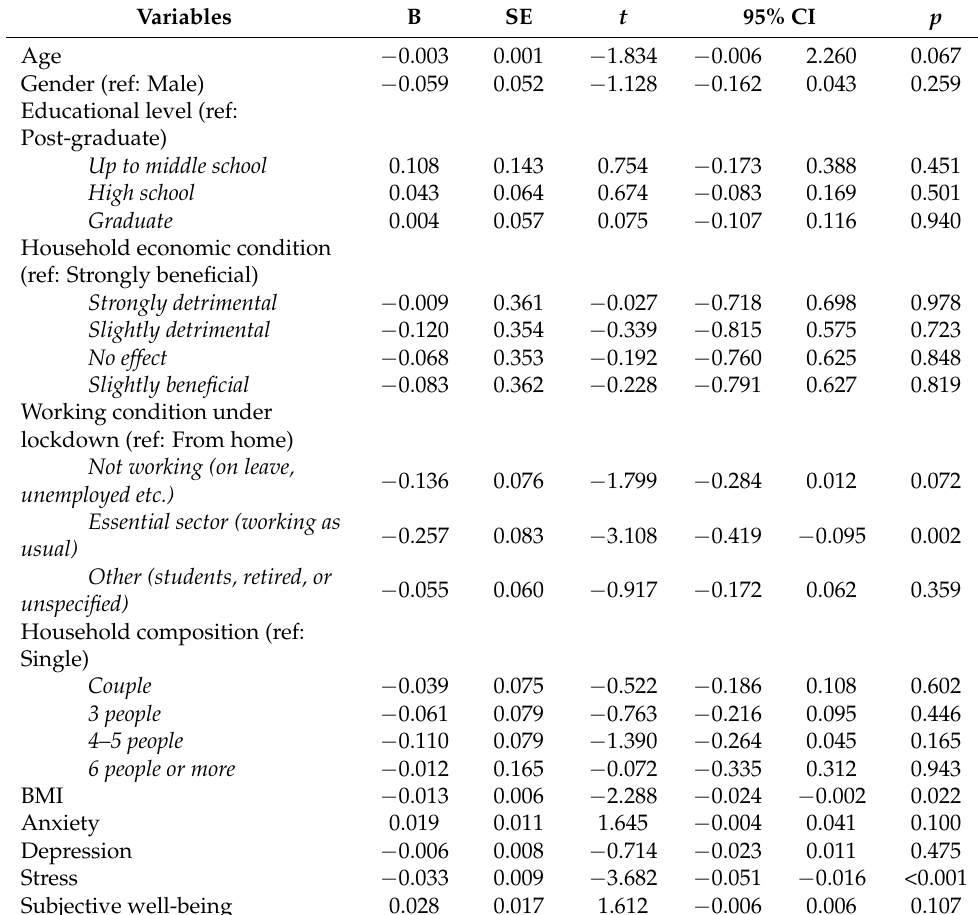
Table 5. Multiple linear regression analyses with HST index as dependent